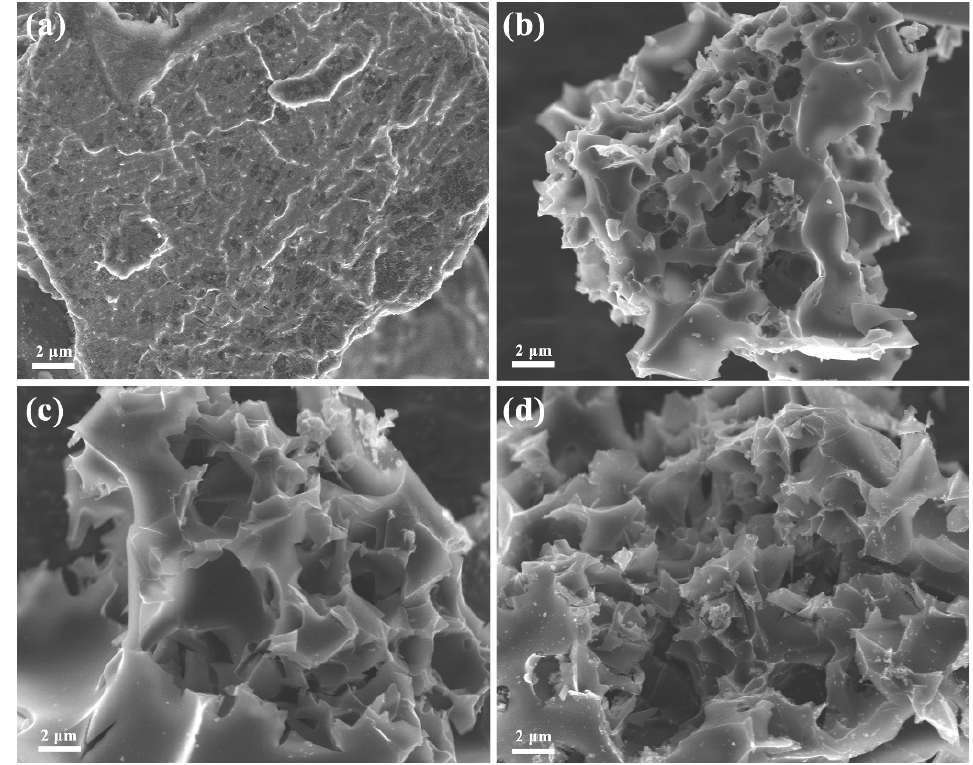
Figure 1. SEM images: ( a ) MGCs-0; ( b ) MGCs-1; ( c ) MGCs-2; ( d ) MGCs-3.